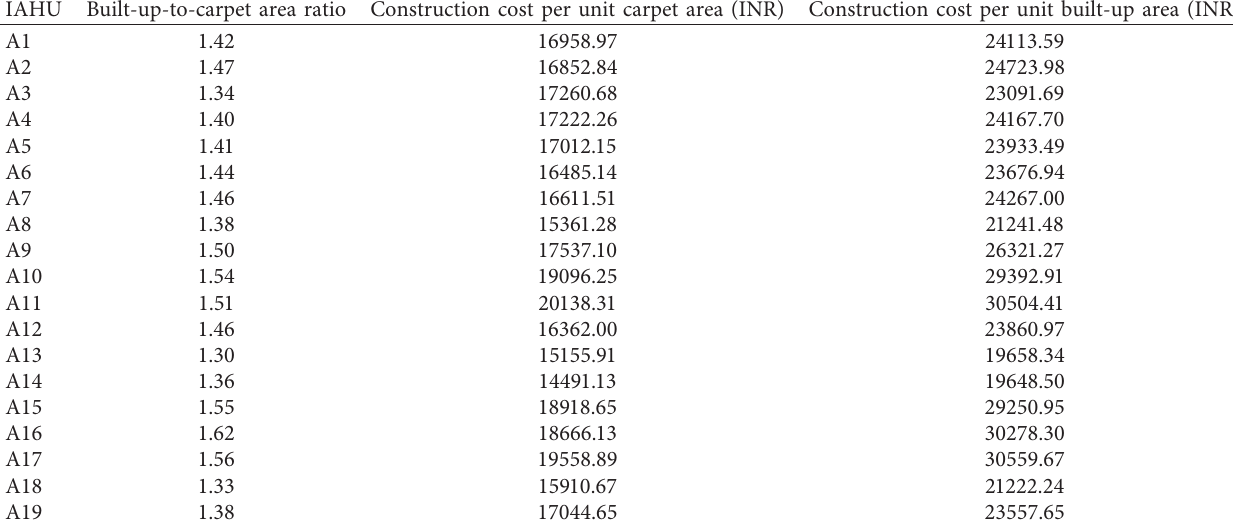
Table 5: Built-up-to-carpet area ratio and construction cost for selected 30